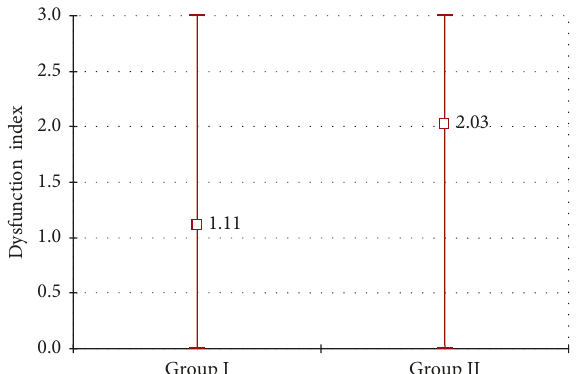
Figure 11: DI index average values and minimal and maximal values after the prosthetic therapy in group I and group II.